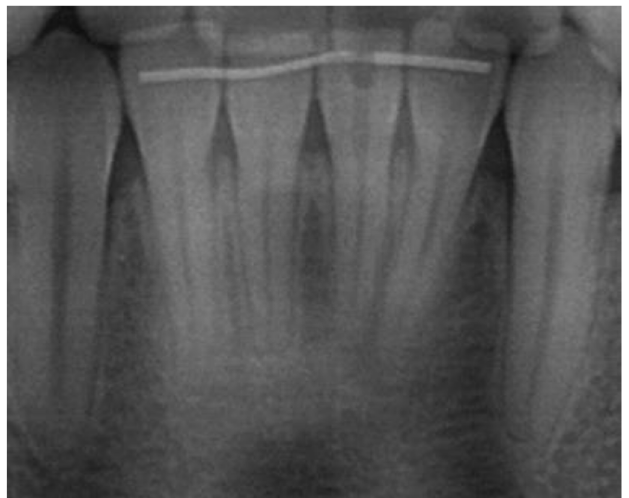
Fig. 2. Postoperative X-Ray after root treatment and apicoectomy of teeth 31 and 32 performed with